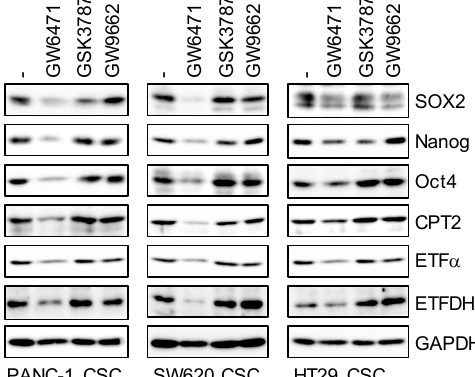
Figure 3. Pharmacological inhibition of PPAR α by its antagonist GW6471 causes the loss of stem cell marker expression. Cells treated with 5 µ M PPAR antagonist (GW6471: PPAR α , GSK3787: PPAR δ , and GW9662: PPAR γ ) were subjected to immunoblot analyses of indicated proteins. Similar results were obtained from two independent biological replicates.